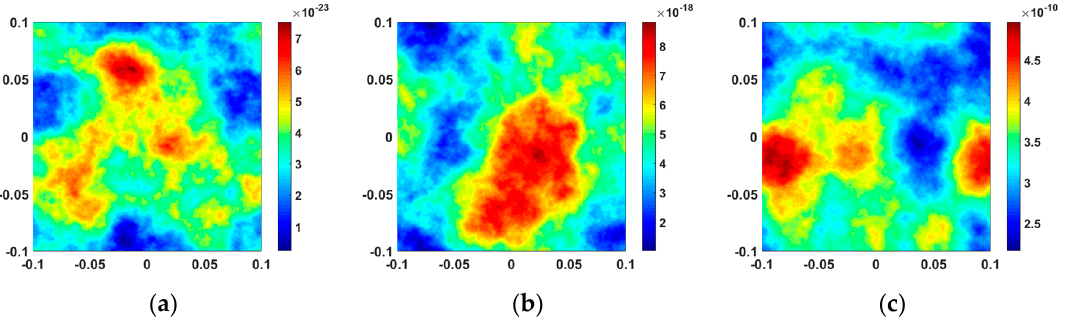
Figure 2. Strength of atmospheric turbulence. ( a ) Weak. ( b ) Moderate. ( c )